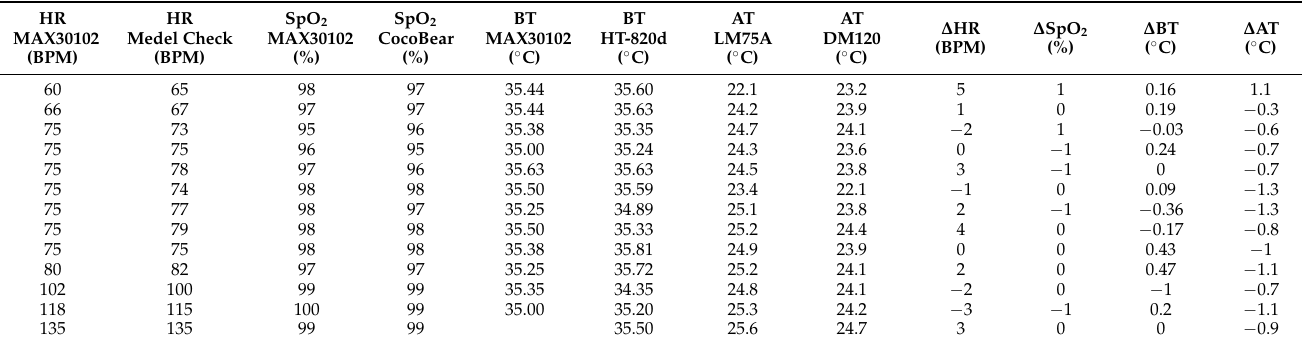
Table 5. Comparison between measures provided by the smart garment with those provided by reference instruments.